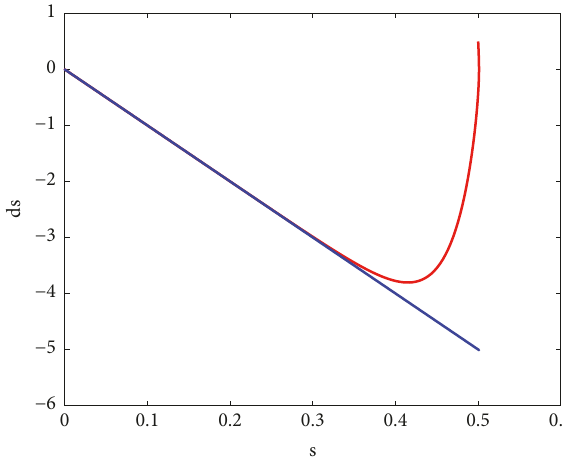
Figure 5: The control results of NNSMC versus PID control.